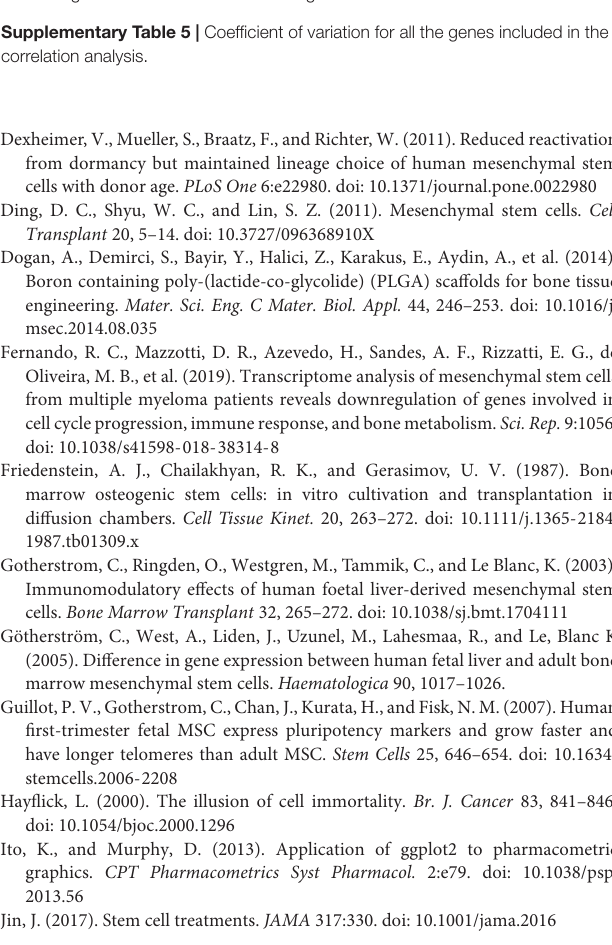
Supplementary Table 1 | The full list of up- and down-regulated genes integrated by RRA method. Supplementary Table 2 | The details of all the robust DEGs. Supplementary Table 3 | The list of DEGs ranked by log FC from large to small. Supplementary Table 4 | Correlation coefficient and P -values for the correlation between genes in sub-network and hub genes. Supplementary Table 5 | Coefficient of variation for all the genes included in the correlation